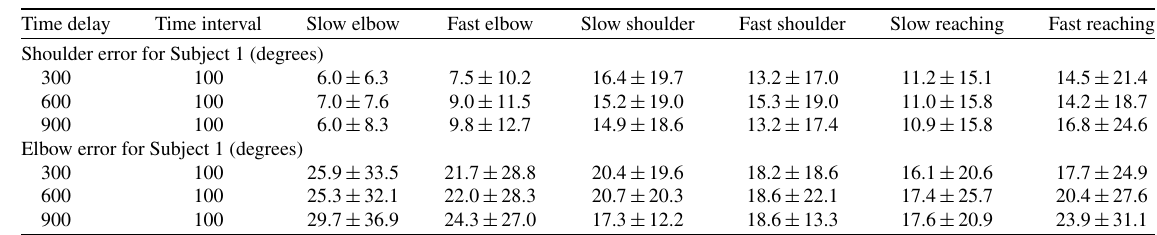
Table 3 The error of shoulder position and elbow position for Subject 1 for each type of movement. The TDNNs shown here had 10 neurons in the hidden layer and a delay interval of 100ms.